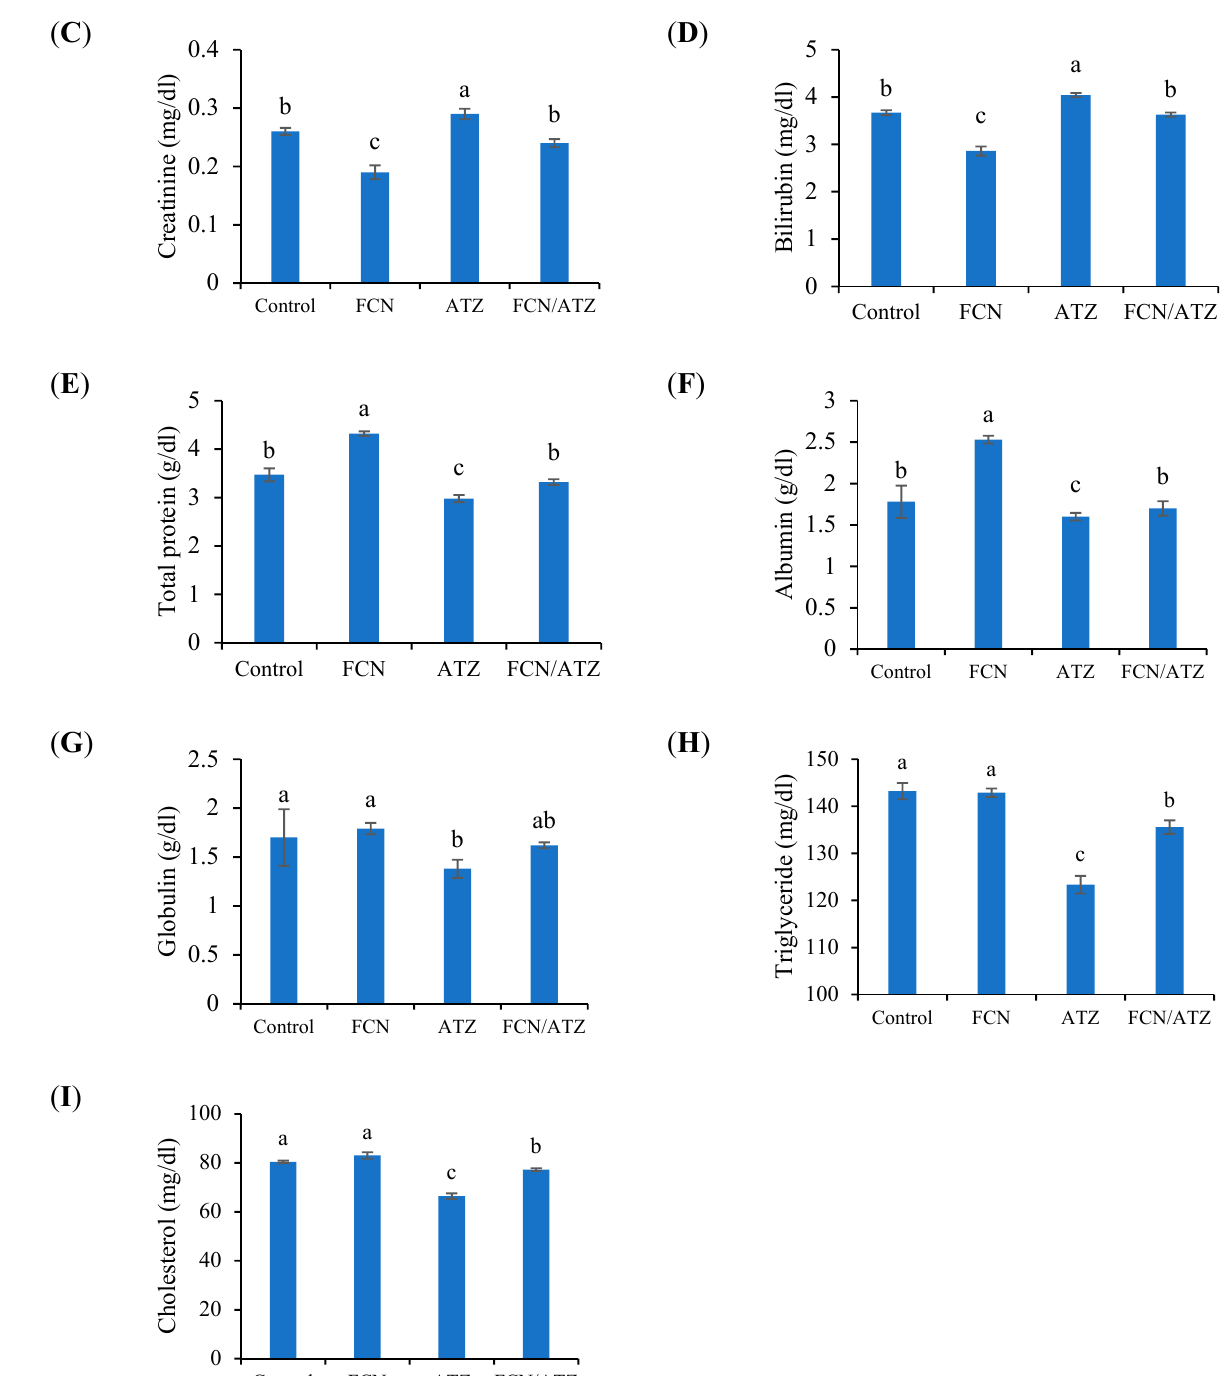
Figure 2. The blood biochemical traits of Nile tilapia fed fucoidan and exposed to atrazine. Bars present means ± S.E. with different letters; differ significantly ( p < 0.05). The groups are the control, fish fed dietary fucoidan (FCN), fish fed basal diet and exposed to atrazine (ATZ), and fish fed FCN and exposed to ATZ (FCN/ATZ). Blood uric acid ( A ), urea ( B ), creatinine ( C ), bilirubin ( D ), total protein ( E ), albumin ( F ), globulin ( G ), triglycerides ( H ), and cholesterol ( I ). The activities of liver enzymes (ALT and AST) were higher in ATZ-exposed fish and lower values in fucoidan fed fish ( p < 0.05), while fish exposed to ATZ and fed fucoidan had similar values of ALT and AST with regard to the control ( p > 0.05) (Figure 3A,B).